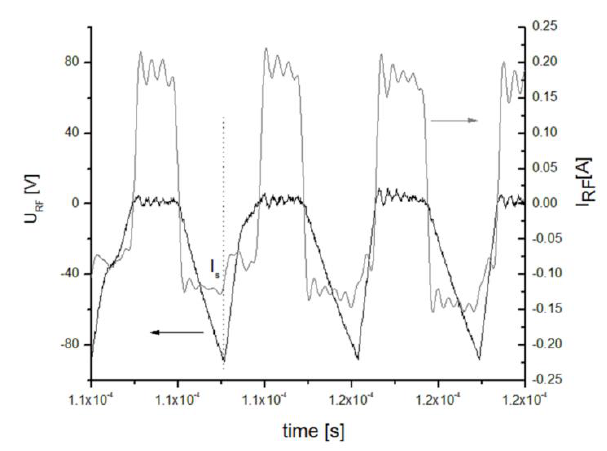
Figure 2. RF current and voltage waveforms on the RF ion flux probe.